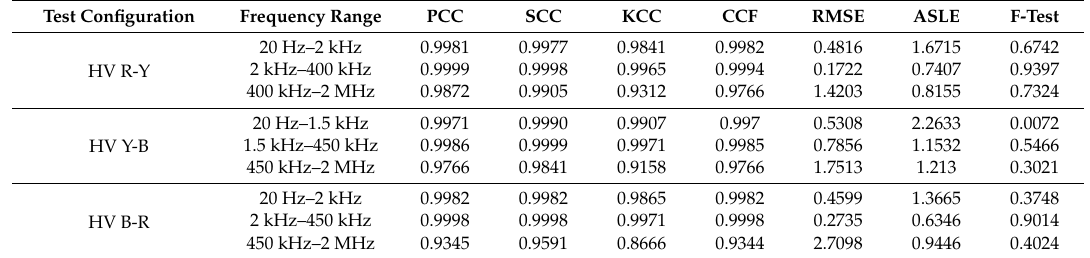
Table 2. Comparison of statistical methods for frequency response interpretation of HV